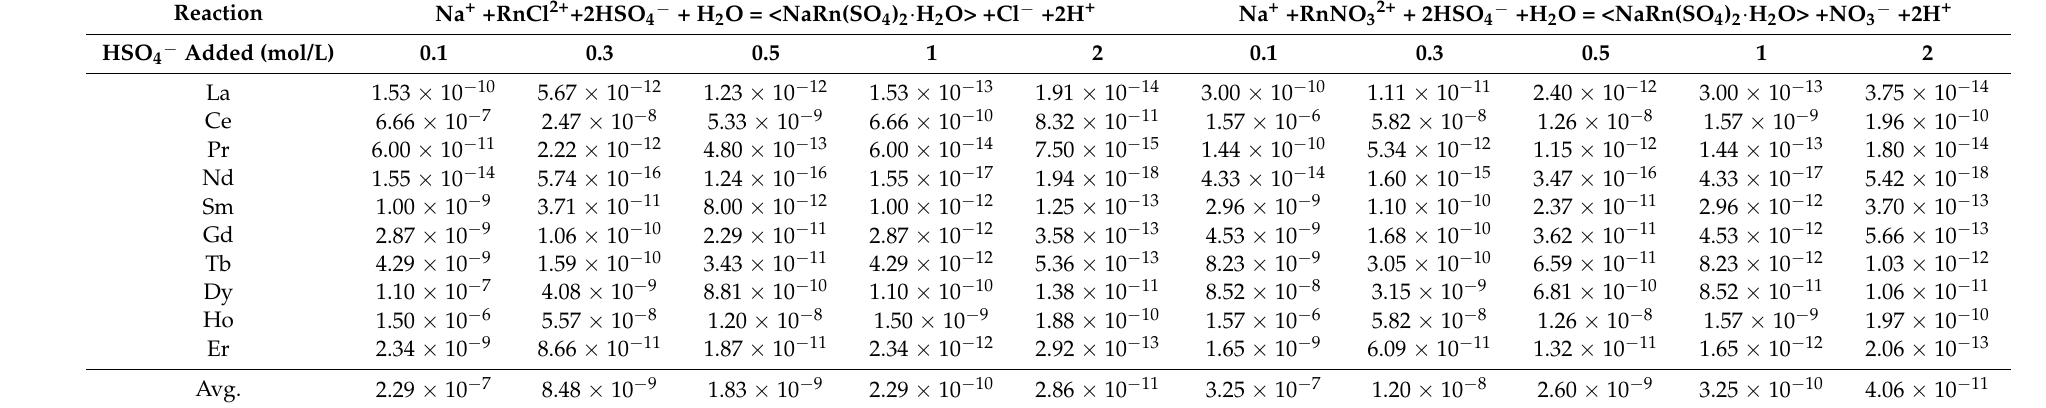
Table 4. Concentrations of RnCl 2+ or RnNO 32+ in equilibrium with sodium double salt at pH 1.